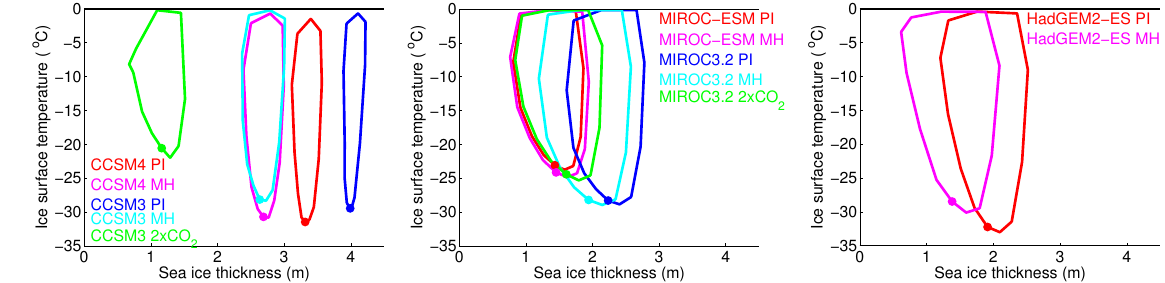
Fig. 8. Seasonal change in ice-surface temperature ( ◦ C) and sea-ice thickness (m) north of 80 ◦ N. The dots mark January and the procession of the seasonal cycle is anti-clockwise. The blue (red) and cyan (purple) lines show the seasonal variation of the PMIP2 (PMIP3) models for the pre-industrial and the mid-Holocene, respectively. The green lines show the seasonal variation of the 2 × CO 2 simulations from the CMIP3. Note that the change in climate state between the PI and the MH (and 2 × CO 2 ) simulations for the CCSM3 are larger than for those of the new version of the model (CCSM4). In the MIROC models and the HadGEM2-ES, which have thinner ice than the CCSM models, the seasonal cycles are larger and the changes in mean ice thickness between the different climates are smaller.